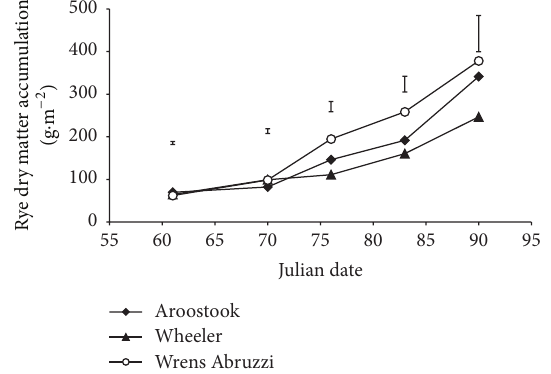
Figure 13: Accumulation of dry matter for three rye varieties over time (Julian dates) during the second year of experiments. Vertical bars represent standard errors at each sampling date.